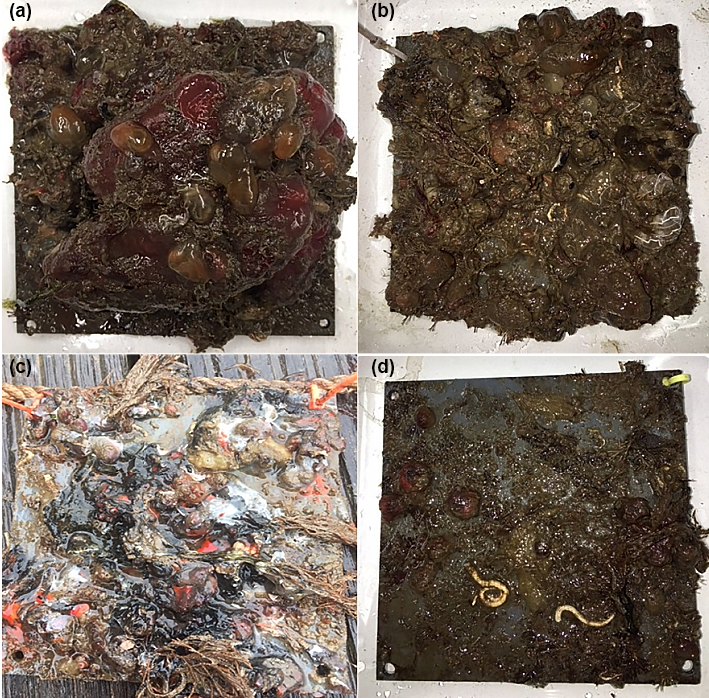
Figure 1. (a) Settlement panel 1 week after exposure to the salinity 33 treatment showing the high biomass and diverse biofouling community that had developed over 2 years at 1.5m depth in a marina off Plymouth, UK. (b) Example of a panel 1 week after exposure to the salinity 20 treatment with many biofouling organisms still alive. (c) A panel 1 week after the salinity 7 treatment showing black sulphurous rotting tissues. (d) Typical panel appearance 1 month after exposure to the salinity 7 treatment showing a much reduced fouling